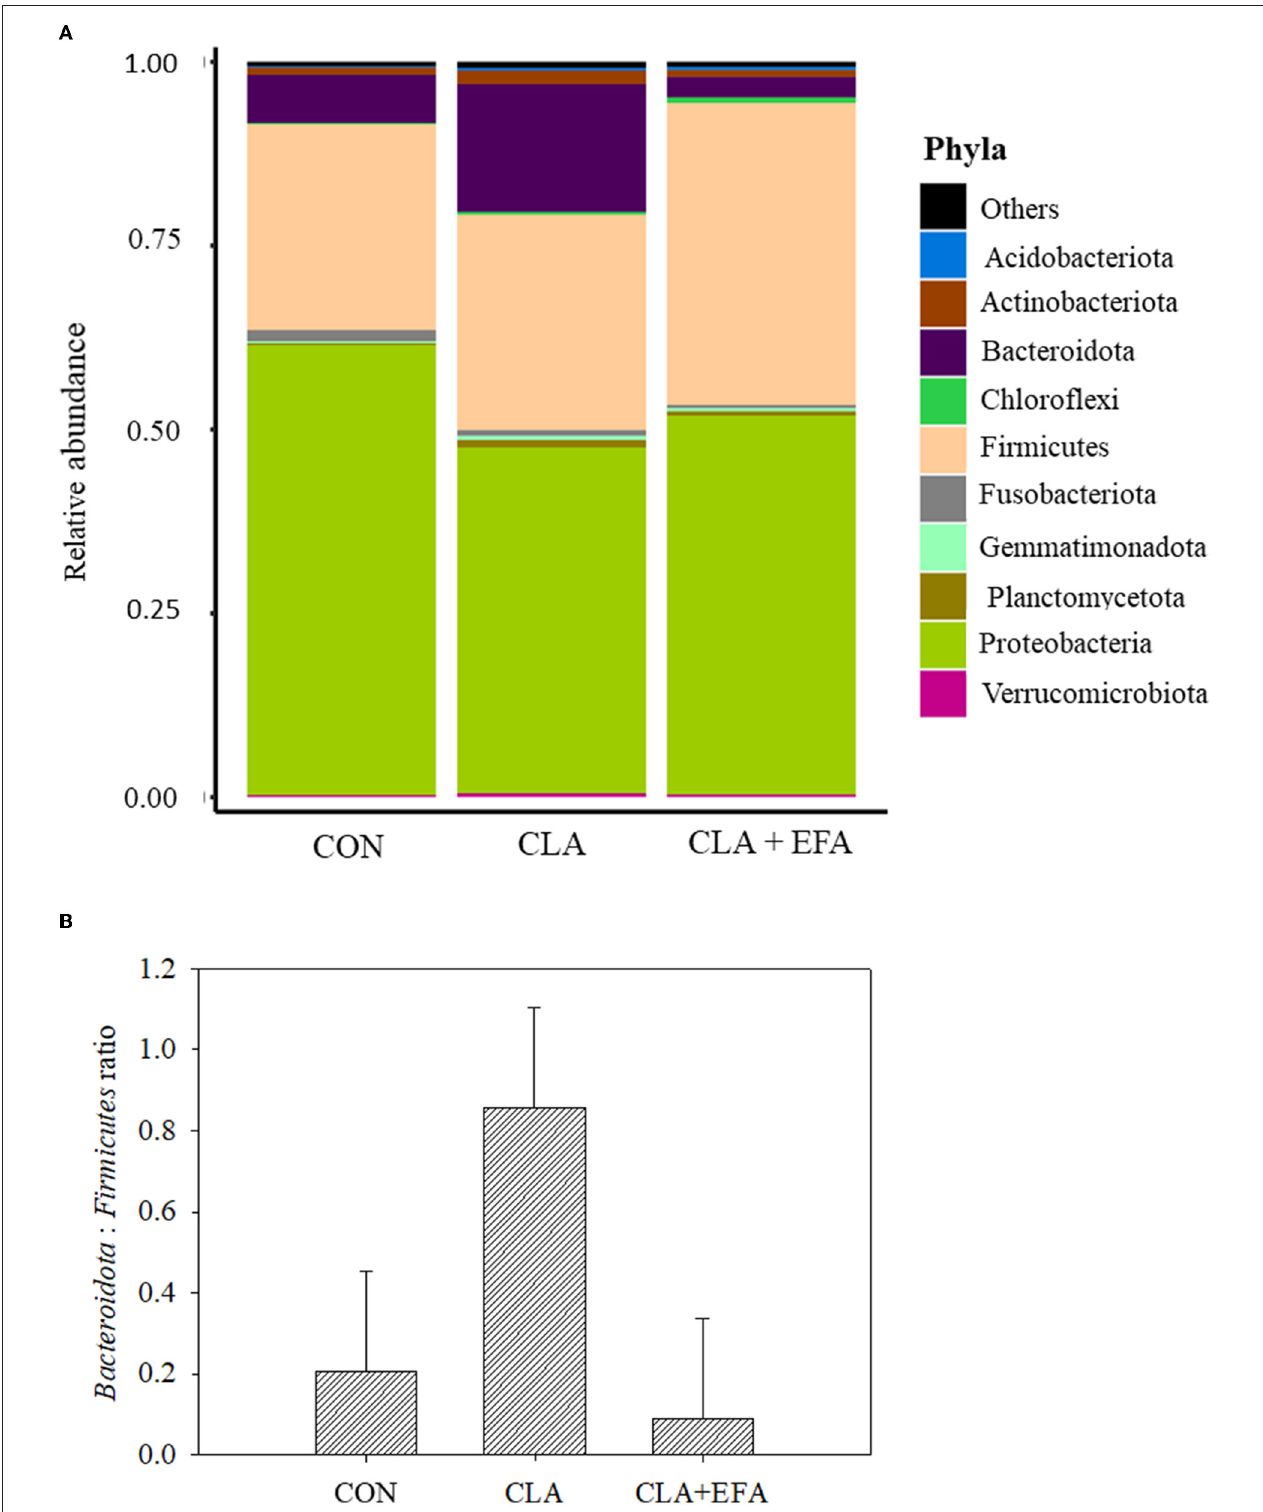
FIGURE 2 | (A) Relative abundance of phyla (A) and Bacteridota: Firmicutes ratio (B) depending on maternal fatty acid supplementation (CLA, conjugated linoleic acid = Lutalin ® . CLA + EFA = Lutalin ® + linseed oil + safflower oil) in the jejunal content of 5-day-old calves (means; n = 3).